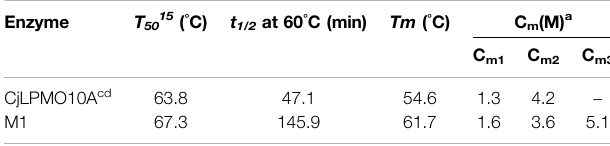
TABLE 1 | Thermodynamic parameters of CjLPMO10A cd and M1. Enzyme